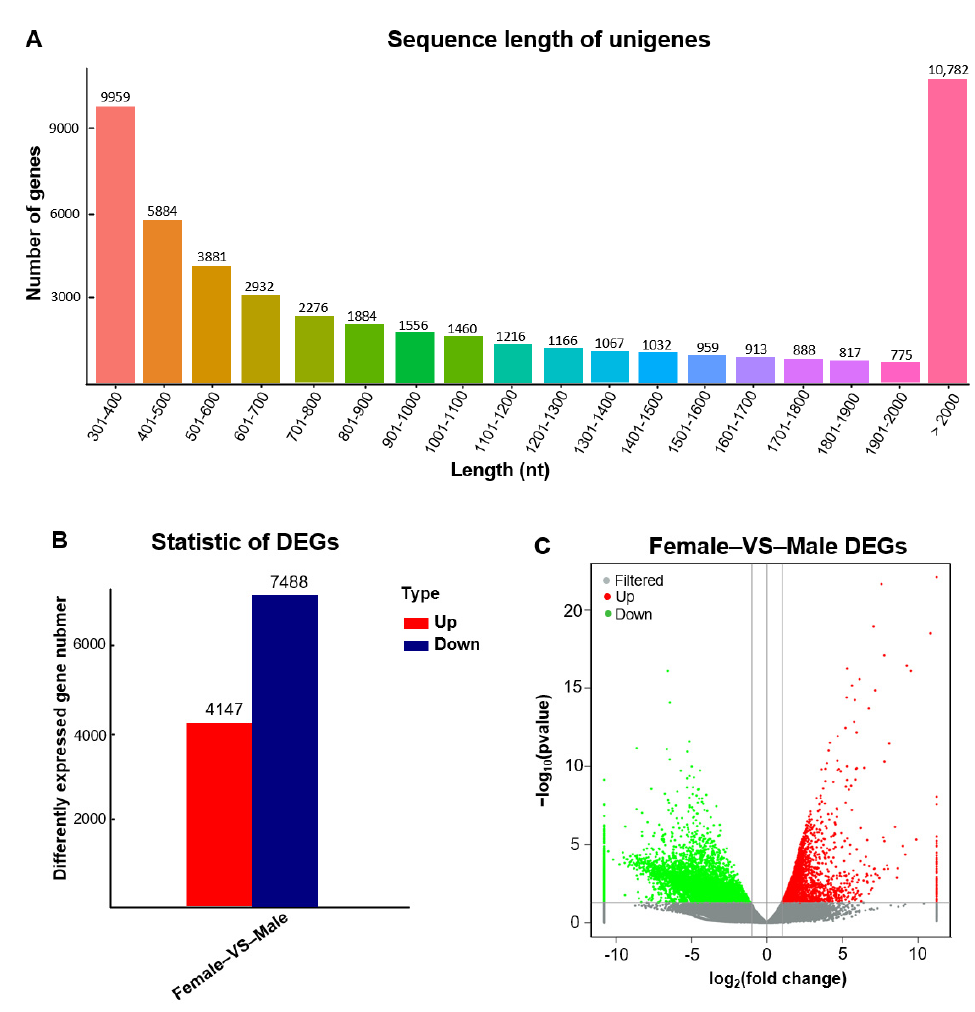
Figure 1. Identification of mRNAs. ( A ) Length distribution of mRNA sequences from six libraries of the A. fasciatus . ( B ) Statistic of differently expressed genes (DEGs) in gonads of A. fasciatus . ( C ) Volcanic map of female and male A. fasciatus differences in gonads.